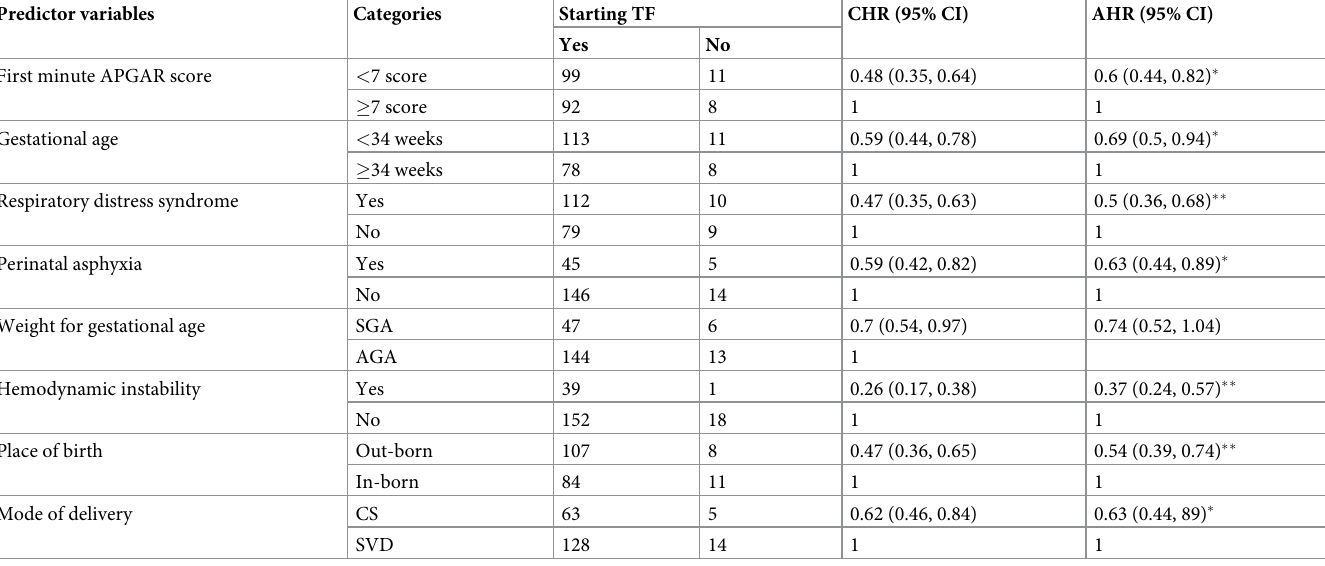
Note � indicates p-value < 0.05 �� indicates p-value � 0.001, both � and �� indicates statistically significant variables in the multi-variable analysis, CHR-crude hazard ratio, AHR-adjusted hazard ratio, CI-confidence interval, SVD- spontaneous vaginal delivery, CS-cesarean